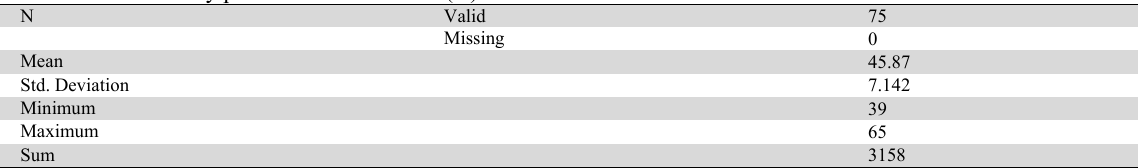
Statistical Variables Dry port Firm Performance (Y)